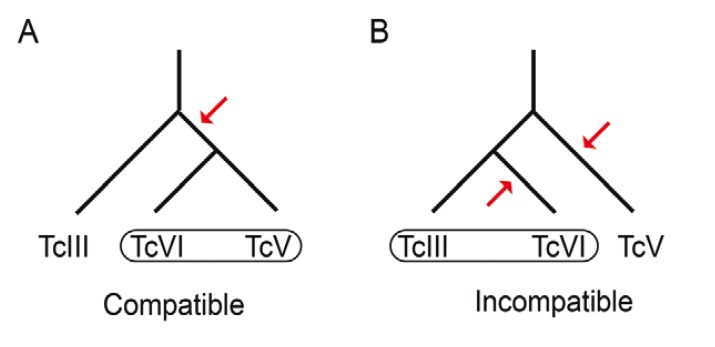
examples of haplotype topologies which are compatible with a single
hybridisation event between TcII and TcIII (A) and incompatible with the
hypothesis of a single hybridisation event (B). Arrows indicate when
hybridisation events could have occurred in the haplotype history. Note that
for A the TcV and TcVI haplotypes diverged after hybridisation event whereas in
B the haplotypes diverged before hybridisation events. It is important to
consider that the topology A is also compatible with multiple hybridisation
events (particularly when the sampled TcIII strain is distantly related to the
parental TcIII strain involved into the hybridisation). The same example
applies for TcII-TcV-TcVI haplotype history.